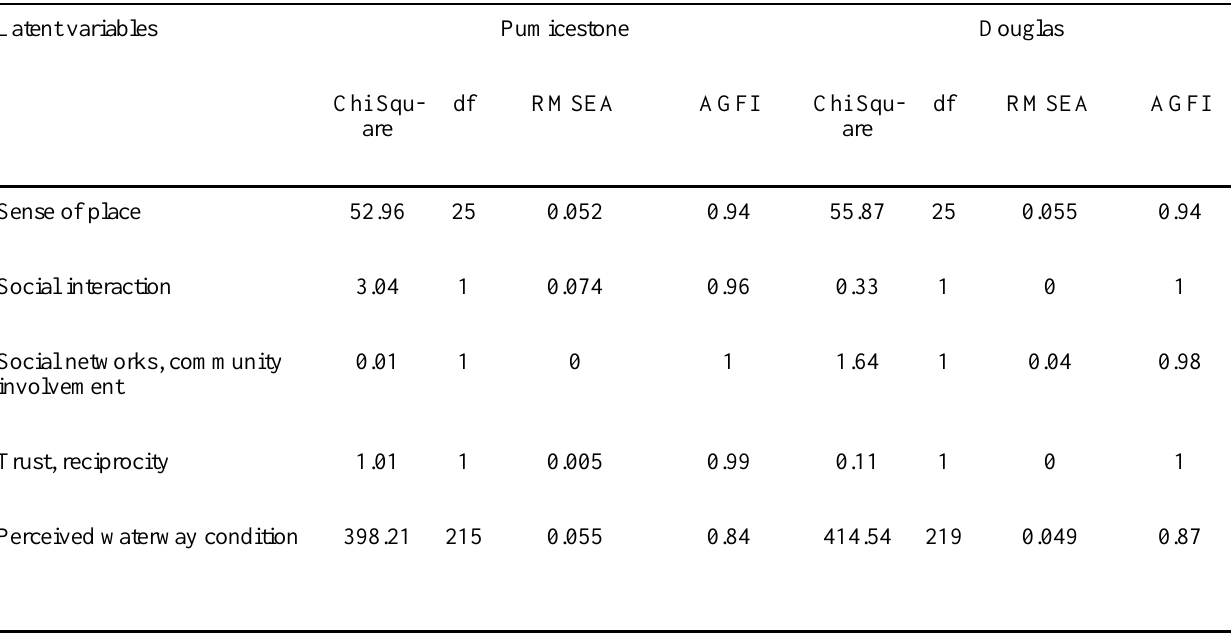
Table 4. Measurement model fit for Pumicestone and Douglas. RMSEA stands for the root mean square error of approximation and AGFI, the adjusted goodness of fit